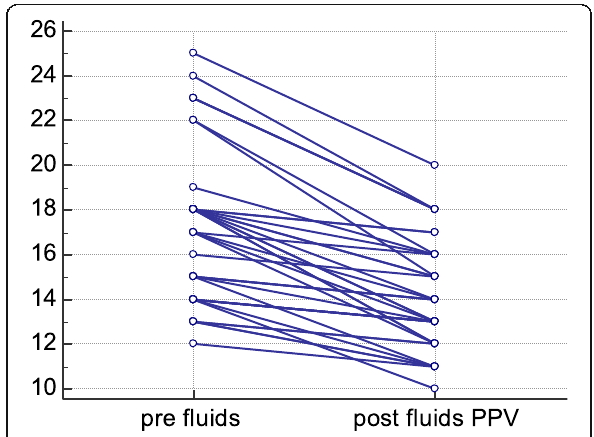
Fig. 1 Individual range of PPV for fluid responsiveness. Individual range of pulse pressure variation (PPV) response after bolus fluid